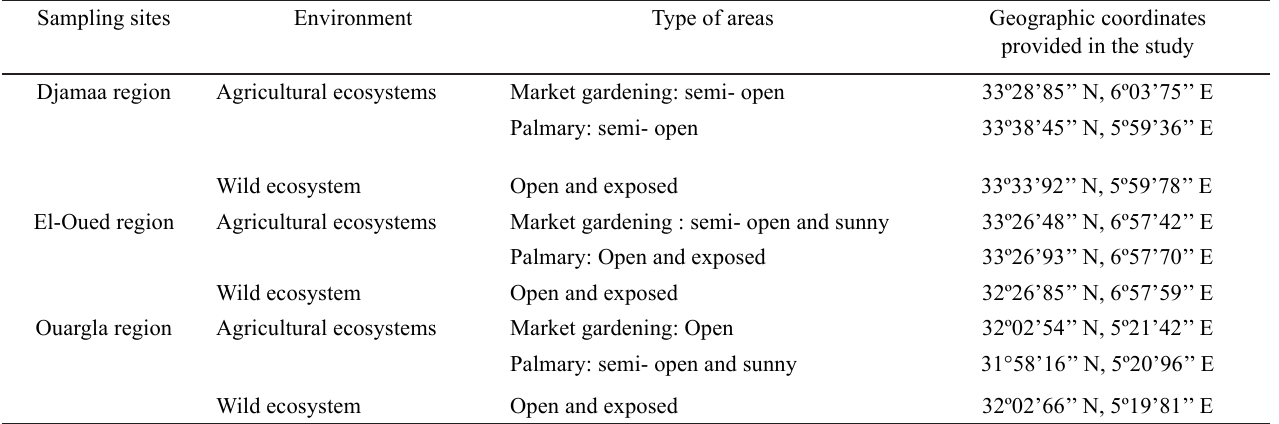
Table 1. Sites where ants were sampled in the northern-east Sahara of